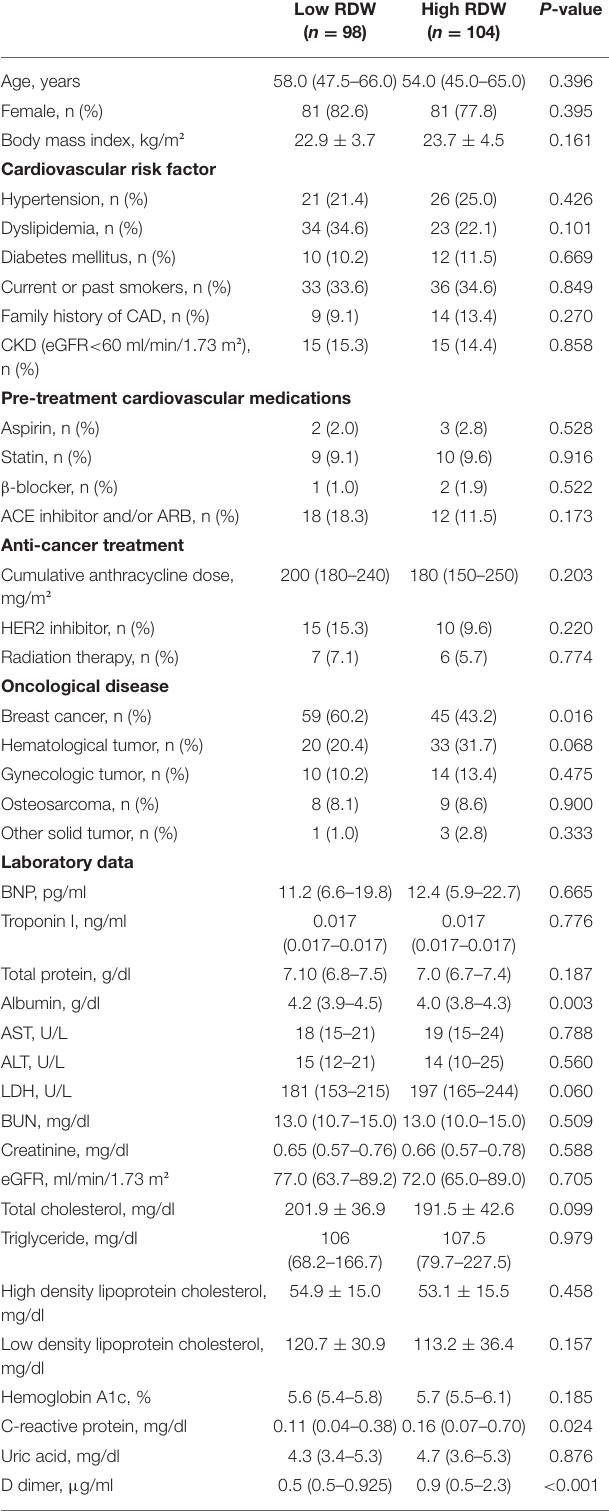
TABLE 1 | Baseline clinical characteristics of patients with high or low RDW.